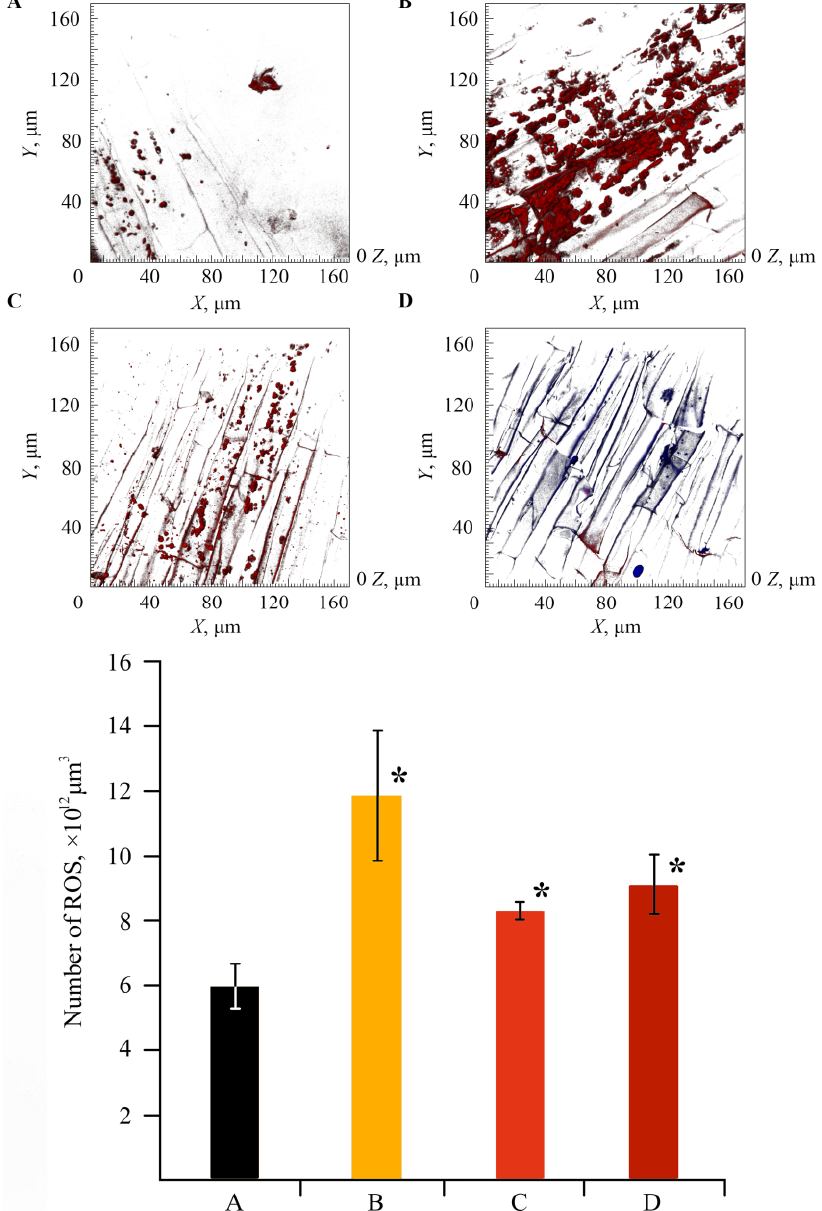
Figure 10. Confocal laser scanning microscopy (CLSM) images of the effect of NCs on ROS production and respective data on the number of ROS in plant tissues in the control ( A ), infected by Cms ( B ), treated with NCs ( C ), treated with NCs and infected by Cms ( D ); * p ≤ 0.01 compared to the control according to the Mann–Whitney test.